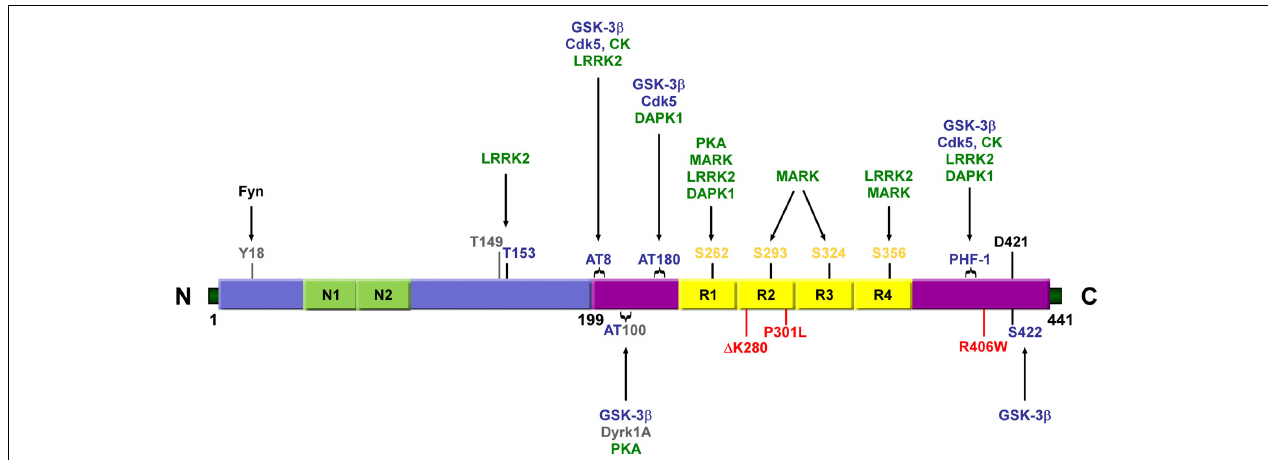
FIGURE 3 | Schematic representation illustrating the various residues in the longest isoform of tau that can be phosphorylated. SP/TP motifs (represented in blue), KXGS motifs (represented in yellow), and other sites (represented in gray) can be phosphorylated by proline-directed kinases (represented in blue) and non-proline directed Ser/Thr kinases (represented in green). Antibody epitopes AT8, AT100, AT180, and PHF-1 comprise dual and triple serine/threonine residues